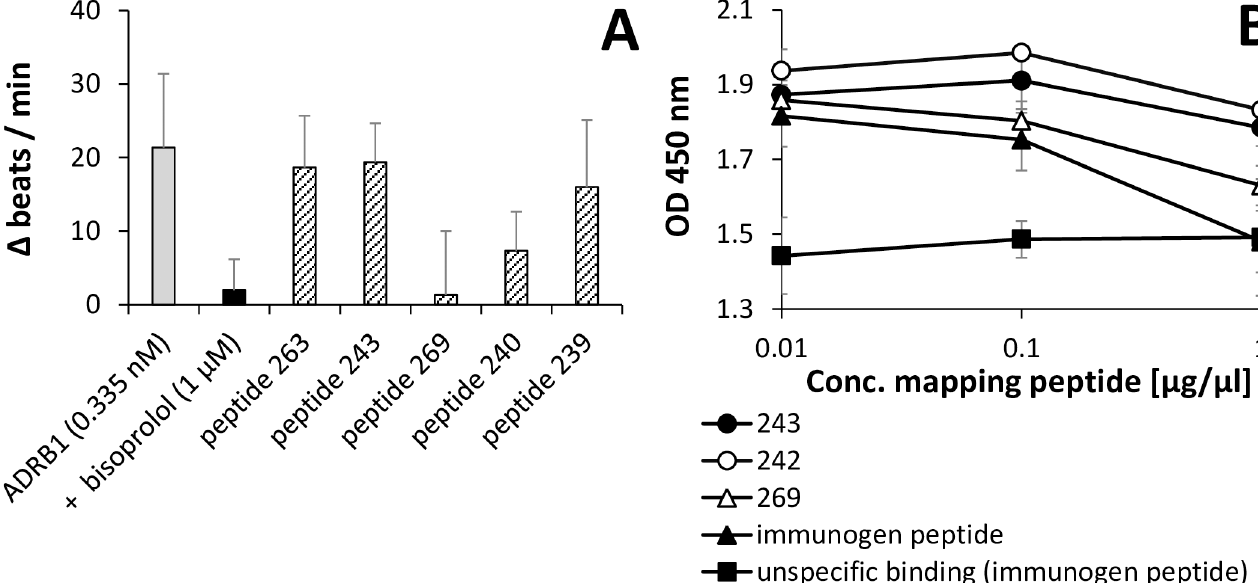
Fig 2. ADRB1-AB epitope mapping experiments. A: The change in beats per minute in rat cardiomyocytes upon delivery of 0.335 nM ADRB1-AB and the influence of various mapping peptides on the ADRB1-AB caused beat rate increase. All peptides (300 nM final concentration) were pre-incubated with the ADRB1-AB sample for 1 hour before adding to the cell culture flask and data is represented as mean ± SD of 6 technical replicates. B: An ELISA using the immobilized immunogen peptide (0.1 μg/well) for binding ADRB1-AB (5 nM), was performed with mixtures of ADRB1-AB and the corresponding mapping peptide (concentration as indicated in the figure). The mixtures were diluted in PBS and incubated for 1 h before adding onto cardiomyocyte cell culture medium preloaded ELISA wells. Anti-goat IgG-POD and H 2 O 2 /TMB served for detection and quantification. The presented data show the absolute measured extinction values free of any computation of two technical